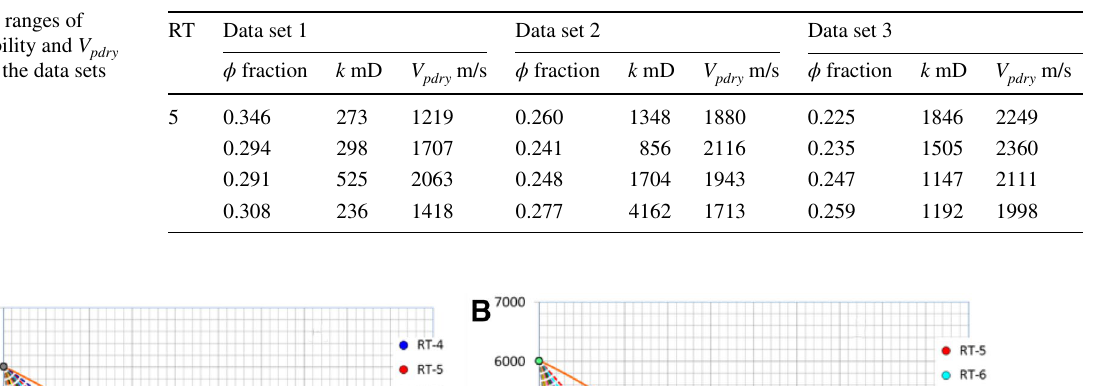
Table 2 Different ranges of porosity, permeability and V pdry of rock type 5 for the data sets 1, 2 and 3